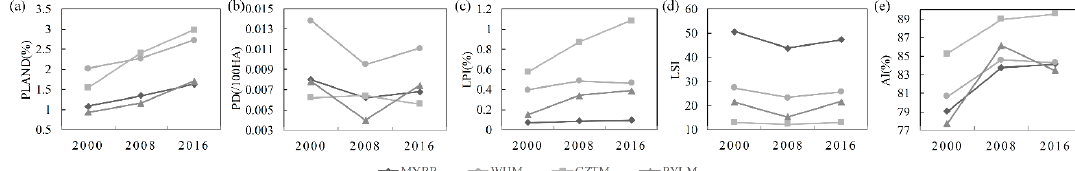
Figure 6. Landscape metrics for the MYRB and the three metropolitan areas from 2000 to 2016: ( a ) PLAND (%); ( b ) PD (per 100 ha); ( c ) LPI (%); ( d ) LSI; and ( e ) AI (%).